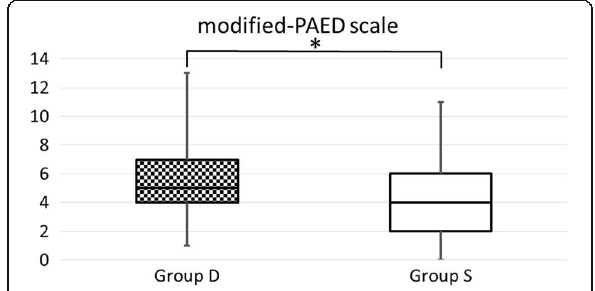
Fig. 2 The degree of emergence agitation in the two groups. D desflurane, S sevoflurane, PAED scale pediatric anesthesia emergence delirium scale. The degree of emergence agitation was more severe in group D than in group S. * p =